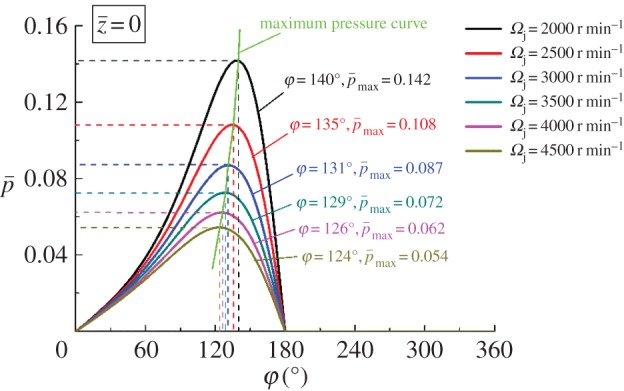
Pressure distribution with different Ωj at z¯=0.